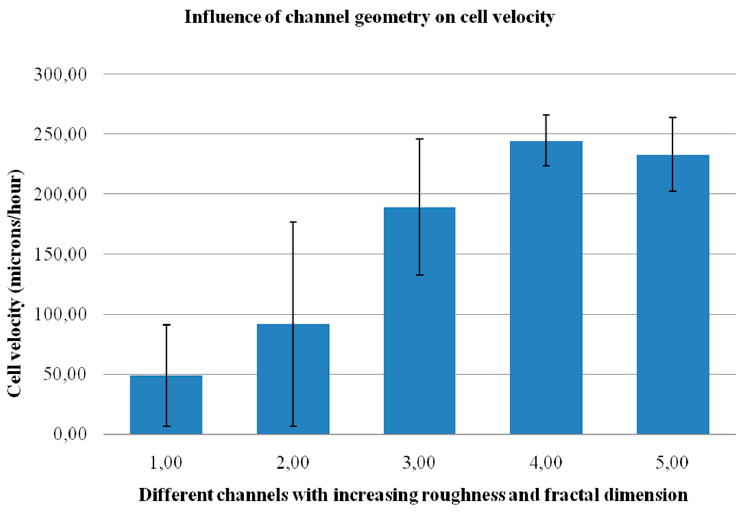
Figure 8. Results from the motility study of cells cultured on the fractal microsystem pre-incubated with TFs medium: Summary of the influence of channel geometry (microtexture) on cell velocity. Table 4. Results from the ANOVA test. Estimates for the different channels with the expected upper and lower limits for cell speed in each channel.